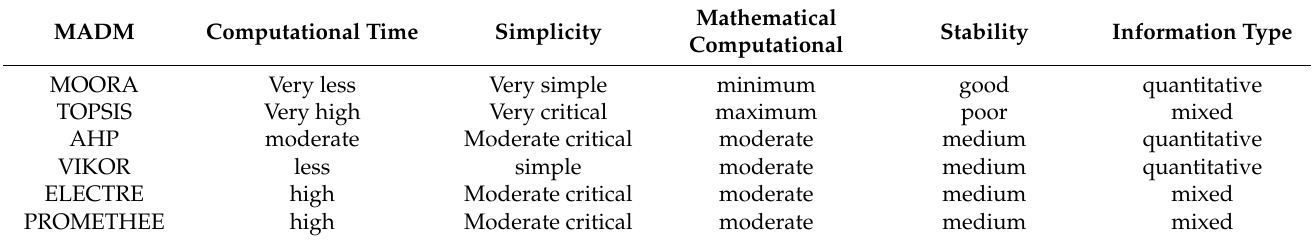
Table 1. Comparison of MOORA with MADM techniques